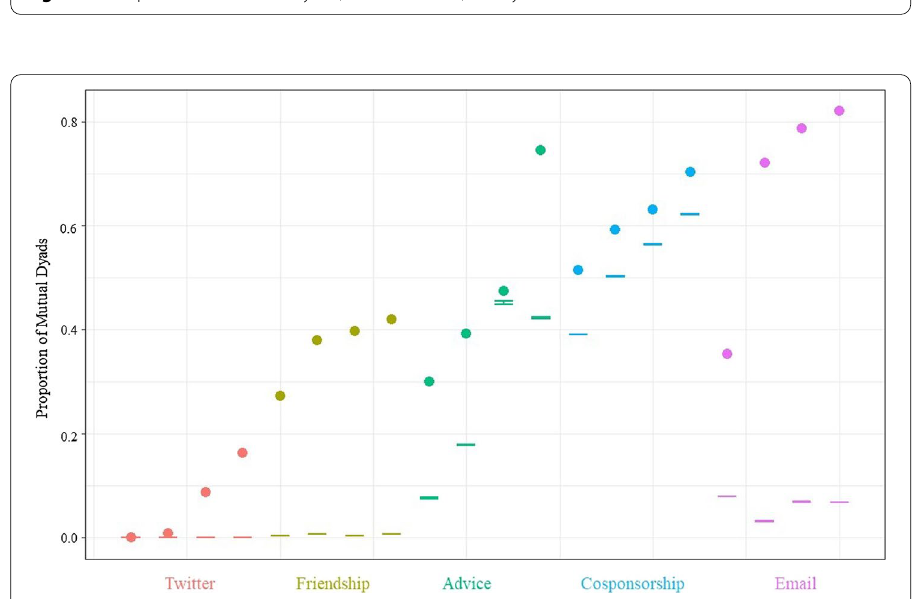
Fig. 2 Proportion of reciprocated dyads in observed networks versus random, conditional networks. 95% confidence intervals represent the range of proportions of mutual dyads in the simulated networks ( p < 0.05; two-tailed test), dots represent proportions in the observed graphs. Colors indicate network